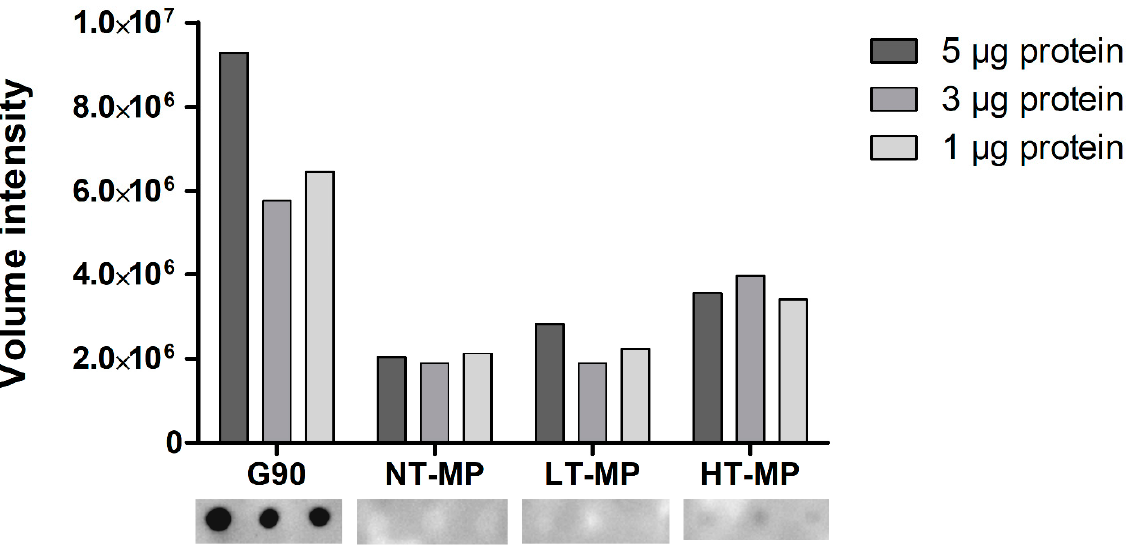
Figure 3. sRAGE dot blot volume intensities (top) and dot blot images (bottom). Cow’s milk protein (MP). MP was non-treated (NT-MP), heated at low temperature (LT-MP), and heated at high temperature (HT-MP), while soy protein, glycated with glucose for 90 min at 100 °C (G90), was used as positive control.